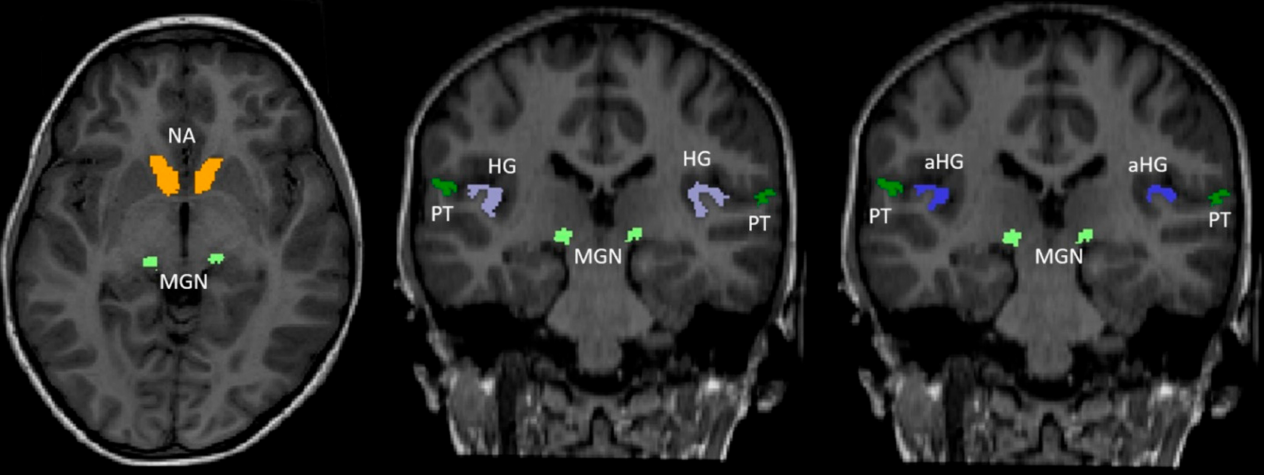
Figure 1. Anatomical structures used in the FreeSurfer analysis overlaid on a coronal reformat of the T1-weighted sequence. Axial and two coronal reformat of the T1-weighted sequence show the color-coded hearing-related brain structures we studied: Heschl’s gyrus (HG, purple, anterior HG (aHG, blue), planum temporale (PT, dark green), medial geniculate nucleus (MGN, light green), and nucleus accumbens (NA,